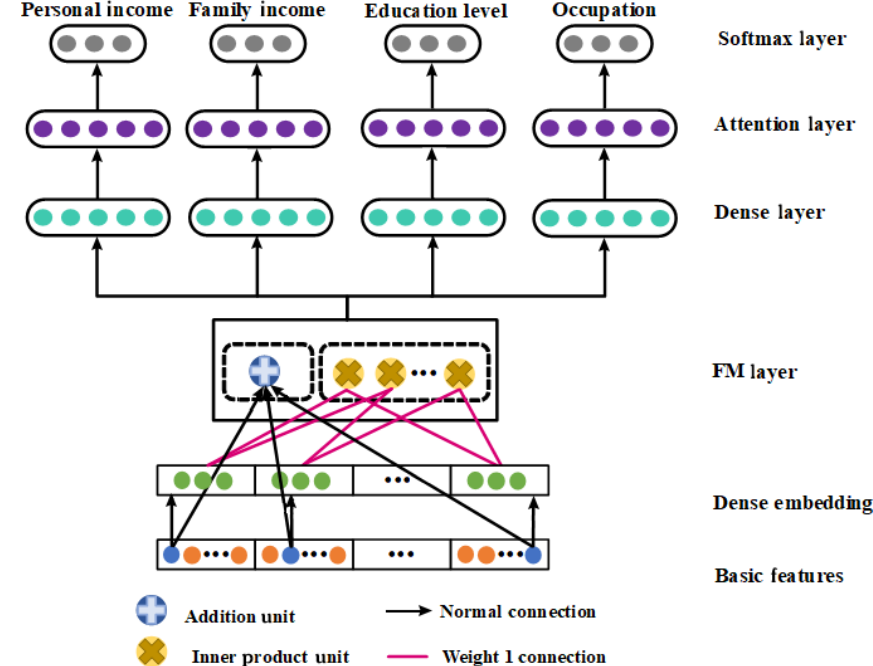
Fig. 2 Architecture of H2SEA